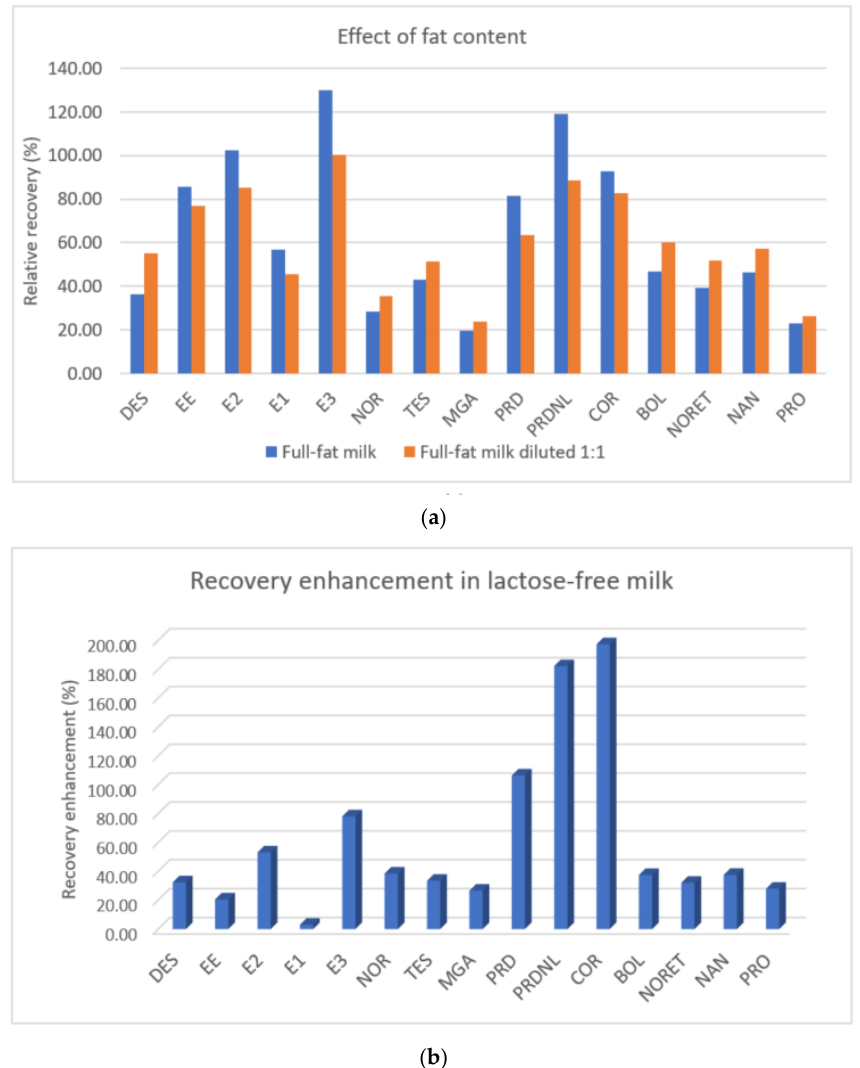
Figure 4. Effects of fat content ( a ) and lactose ( b ) on the extraction efficiency of the optimized FPSE method. Comparisons made with average recoveries ( n = 3).